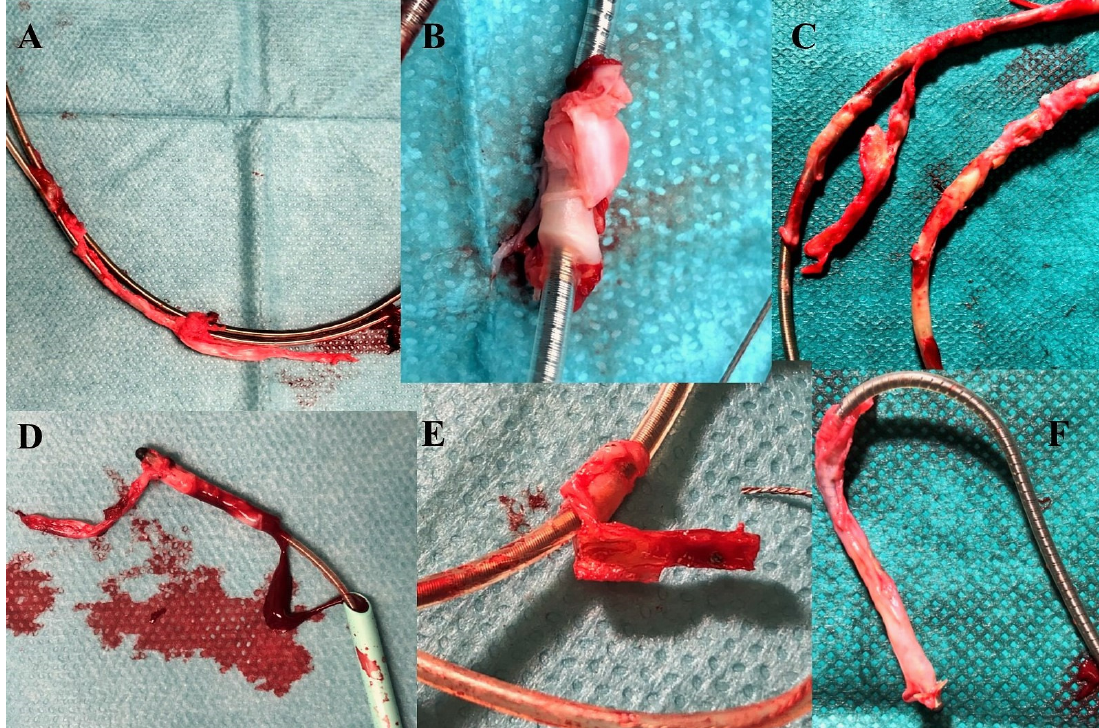
Figure 5. Examples of scar tissue surrounding the leads as seen after extraction ( A , C , D , F ) Examples of scar tissue surrounding the leads as seen after extraction ( B ) Calcification of the scar tissue. ( E ) Ossification of the scar tissue.